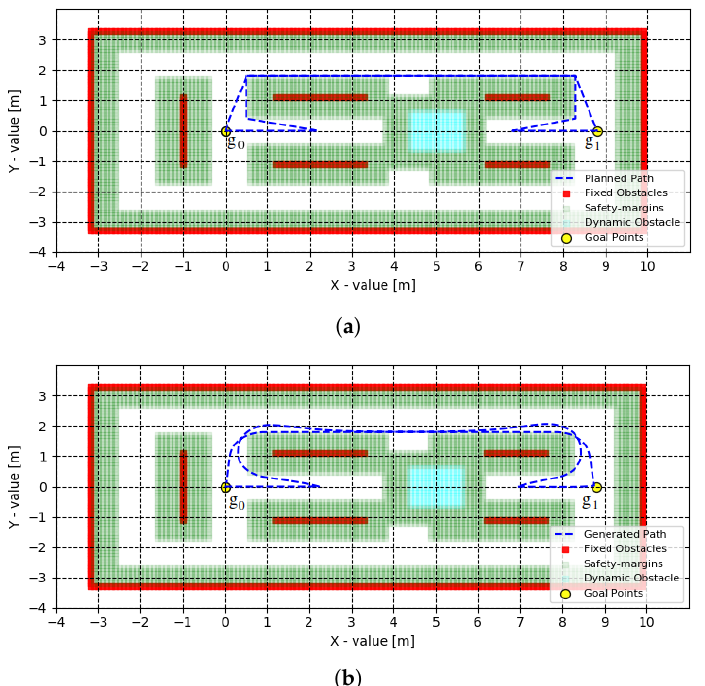
Figure 14. Simulated environment with fixed and dynamic obstacles: ( a ) planned and replanned path using BNM ; ( b ) path executed by the